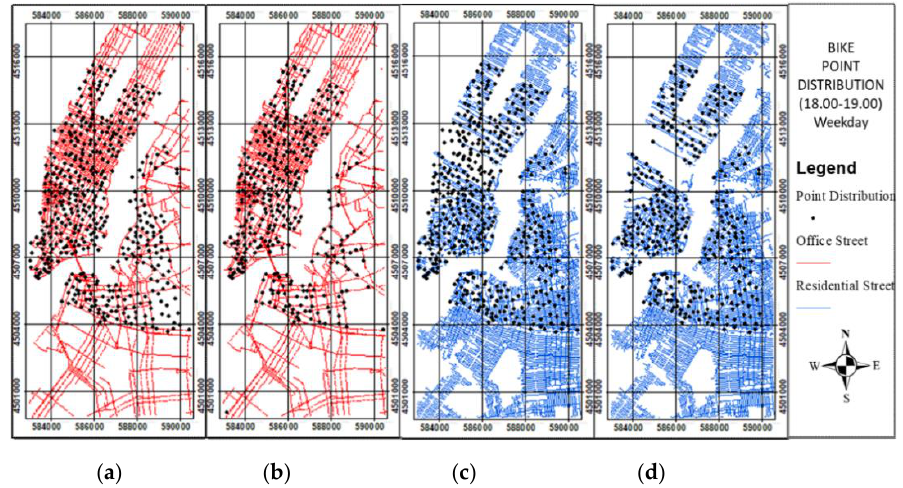
Figure 10. Taxi point distribution at the first weekday peak time (08:00 – 09:00): ( a ) origin before data cleaning; ( b ) origin after data cleaning. ( c ) destination before data cleaning; ( d ) destination after data cleaning.